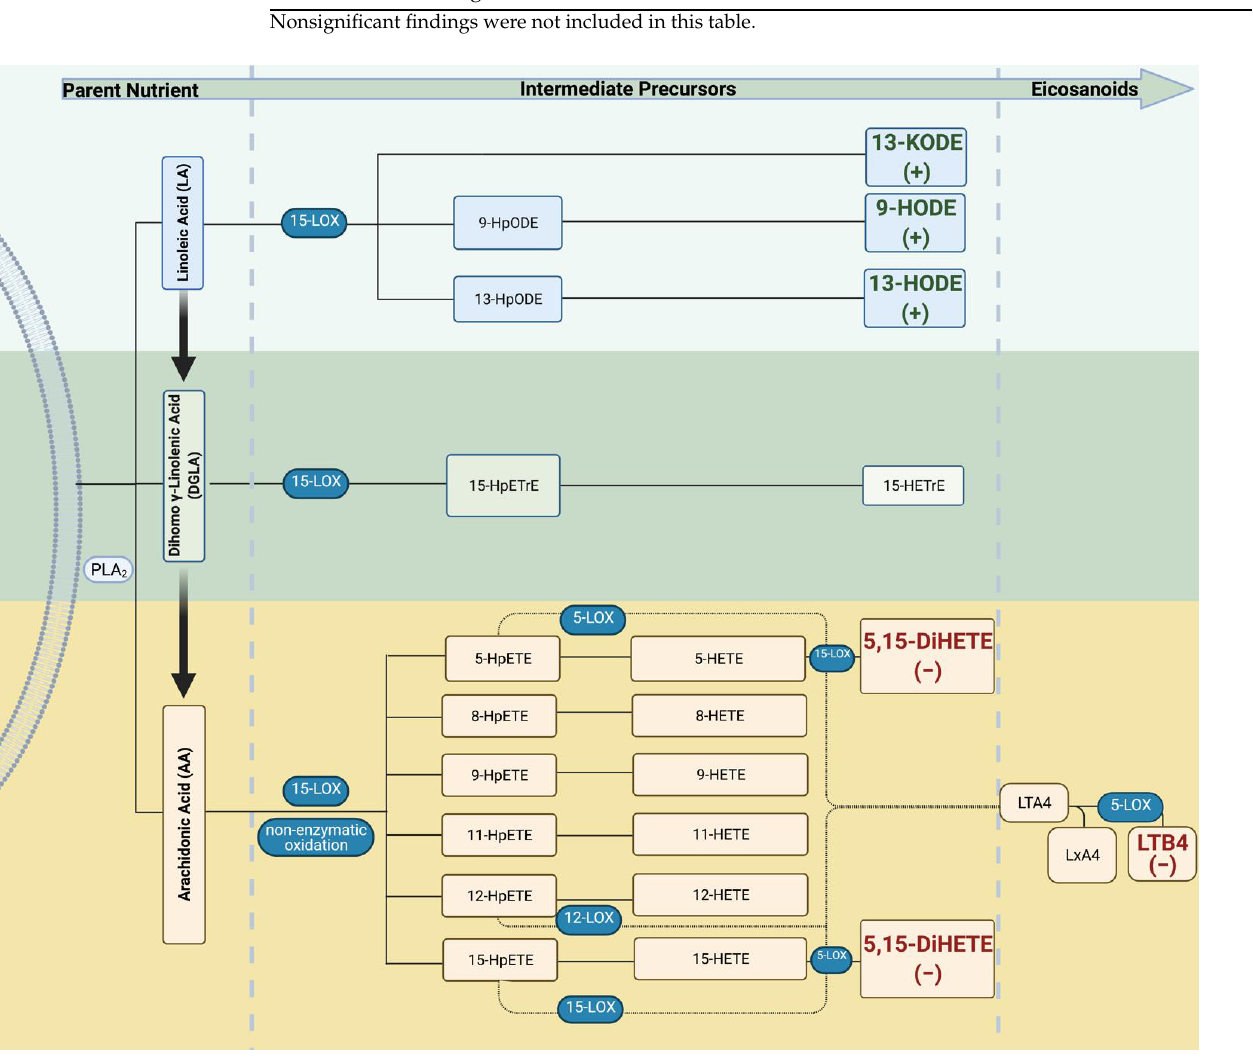
Figure 1. Lipoxygenase (LOX) enzymatic breakdown of n-6 PUFA. Omega-6 FAs are enzymatically cleaved by phospholipase A 2 (PLA 2 ). Parent n-6 FA can then interact with LOX enzymes to be further metabolized into oxylipins that participate in the physiological process. Increases in cord LA metabolites, 13-KODE, 13-HODE , and 9-HODE , predicted an increase in birth length percentile. In contrast, higher levels of maternal 5,15-DiHETE were associated with a decrease in birth weight percentile. Created with BioRender.com (30 December 2021). (+), beta value was positive; ( − ), beta value was negative; HpODE, hydroxyperoxyoctadecadienoic acid; KODE, ketooctadecadienoic acid; HODE, hydroxyoctadecadienoic acid; HpETrE, hydroxyperoxyeicosatrienoic acid; HETrE, hydroxye- icosatrienoic acid; HpETE, hydroxyperoxyeicosatetraenoic acid; HETE, hydroxyeicosatetraenoic acid; DiHETE, dihydroxyeicosatetraenoic acid; LT, leukotriene; LX,